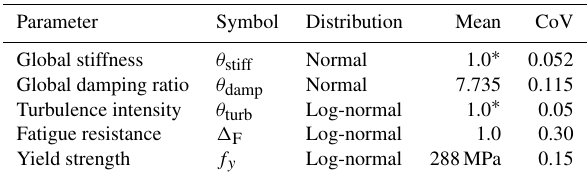
Table 3. Uncertainty modeling details. Quantities marked with ∗ are expressed relative to the respective deterministic values.